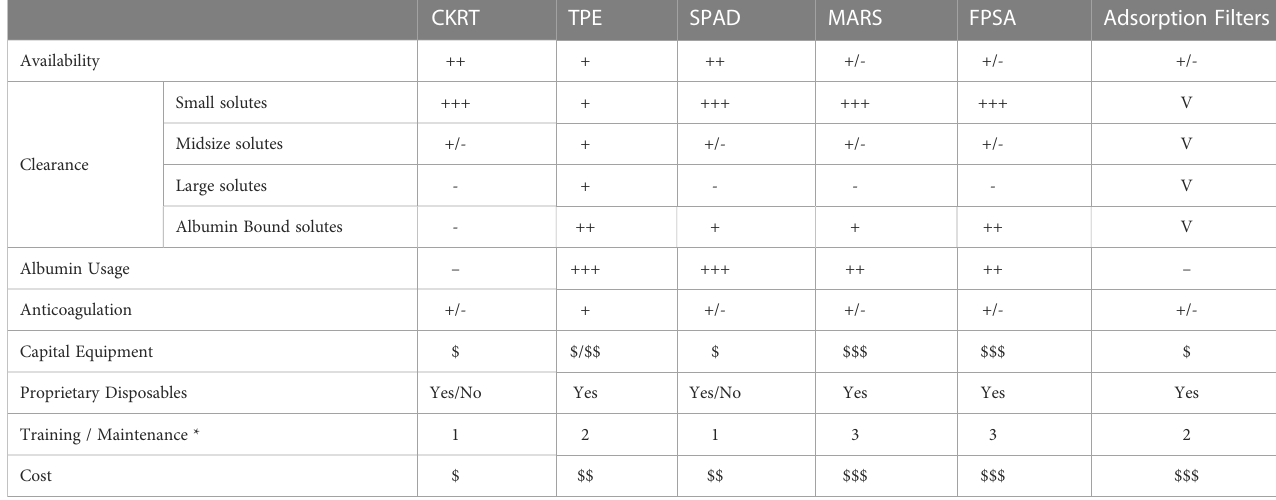
TABLE 1 Comparative of technical aspects between extracorporeal liver assist